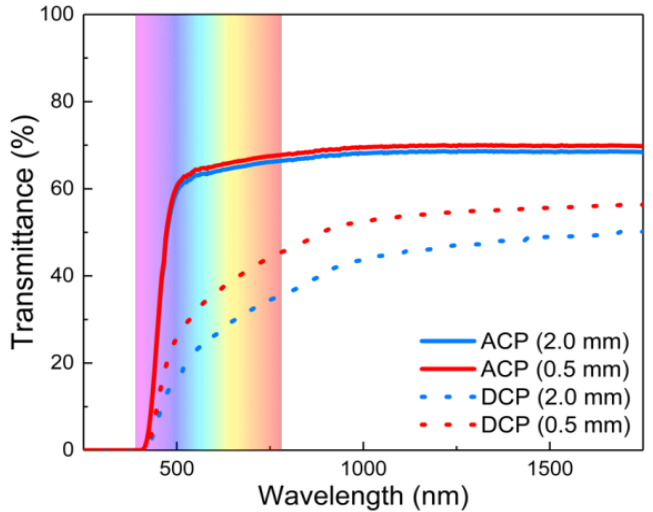
Figure 7. The optical transmittance of the crystal wafers fabricated from the crystal 0.02PSmN- 0.68PMN-0.30PT under ACP and DCP.